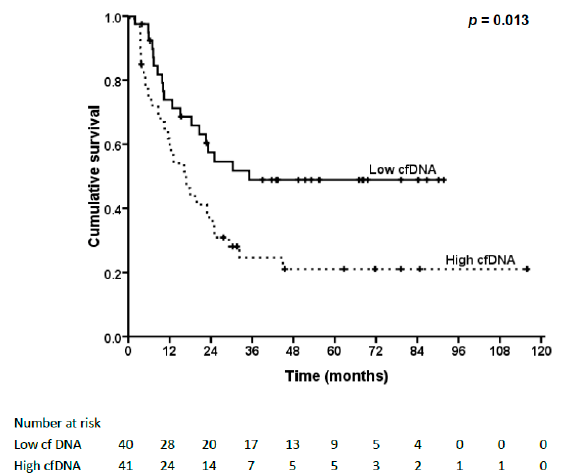
Figure 2. Kaplan–Meier survival curve and log-rank test of different cfDNA levels in disease-free survival (DFS) of esophageal squamous cell carcinoma (ESCC) patients. Patients with lower cfDNA levels had significantly better DFS ( p = 0.013).